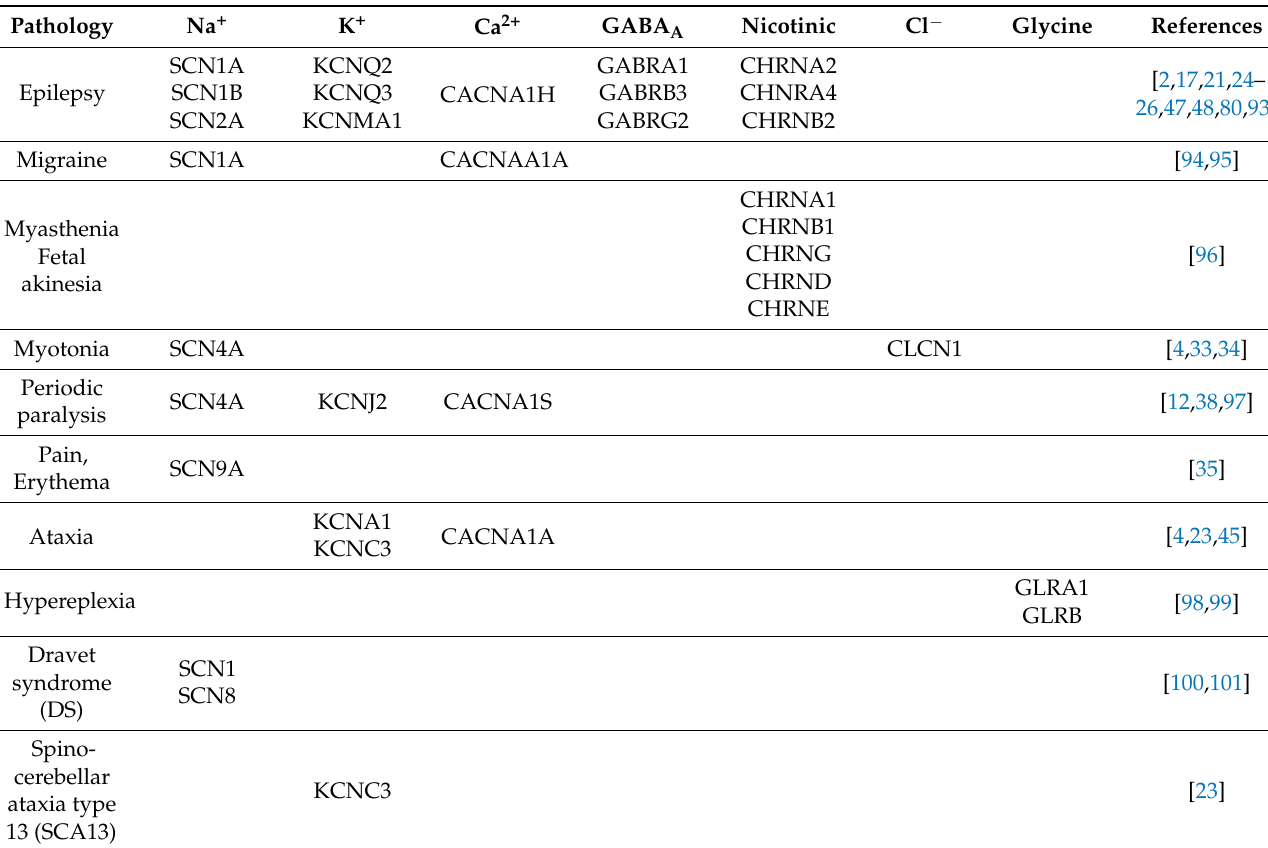
Table 2. Summary of selected genetic causes of CNS